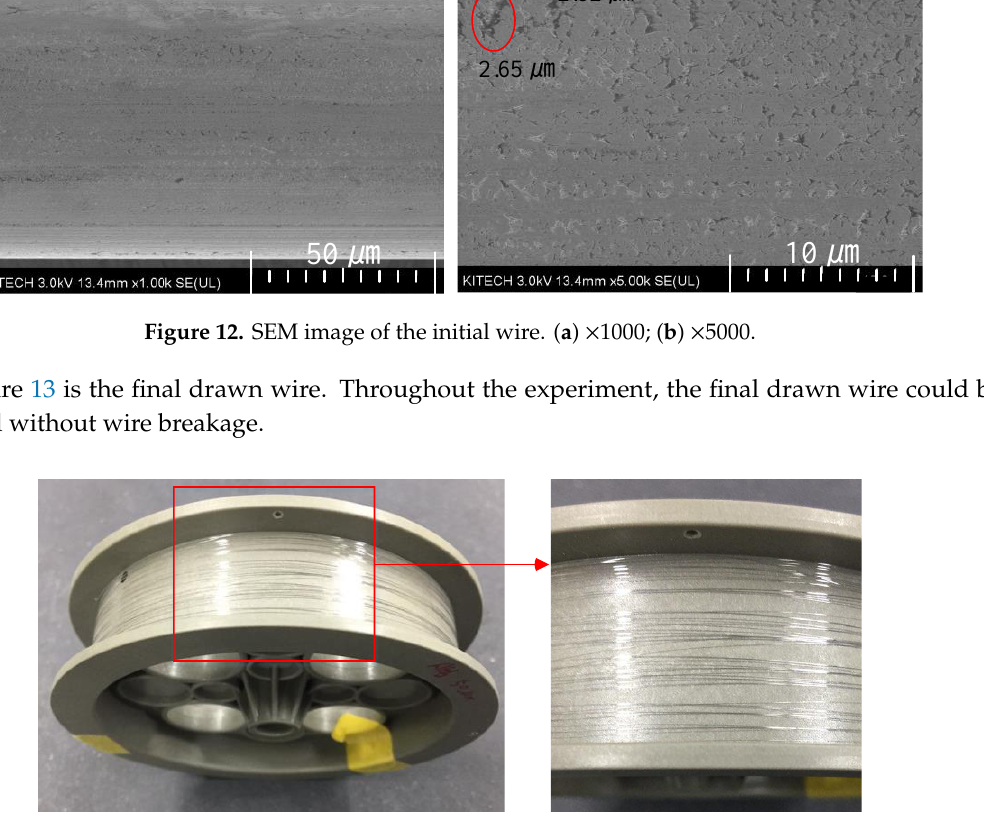
Figure 13. Final drawn wire.